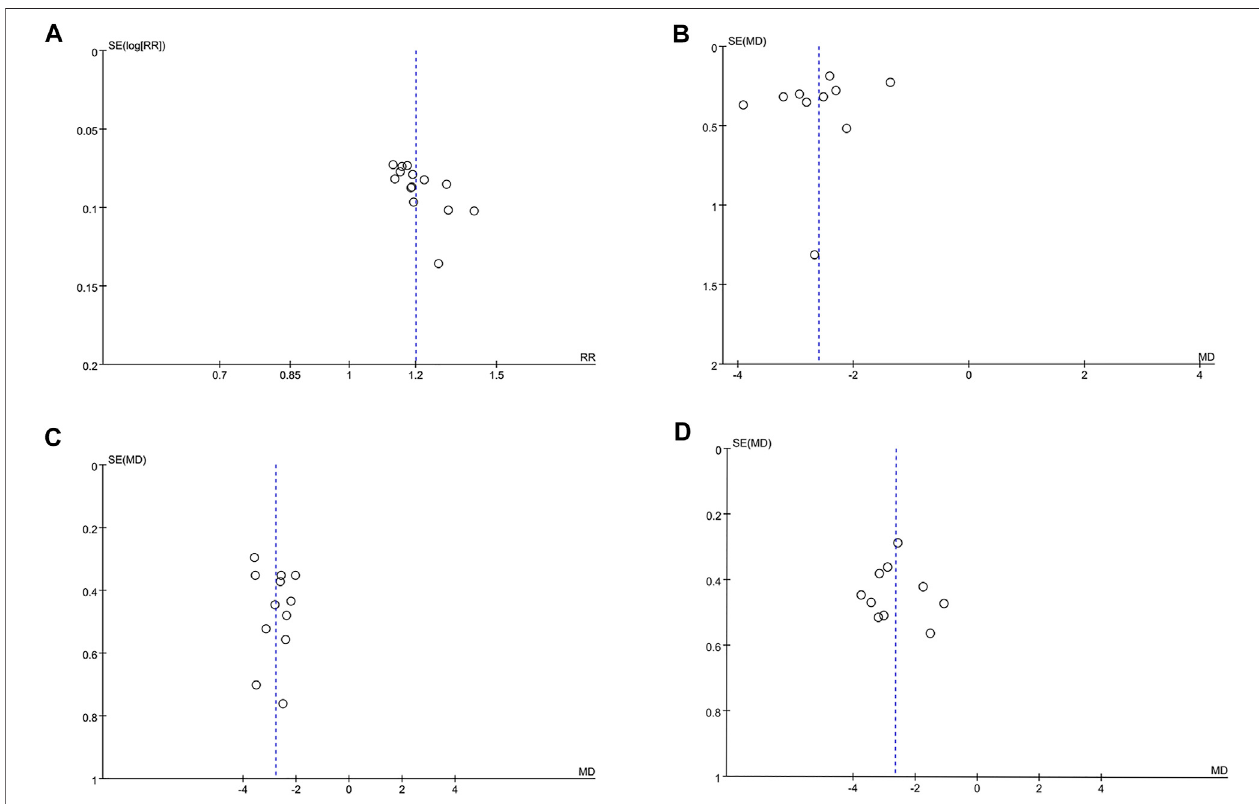
FIGURE 5 | The funnel plots for assessing publication bias. (A) Clinical ef fi cacy rate. (B) Antipyretic time. (C) Cough disappearance time. (D) Lung rale disappearance time.